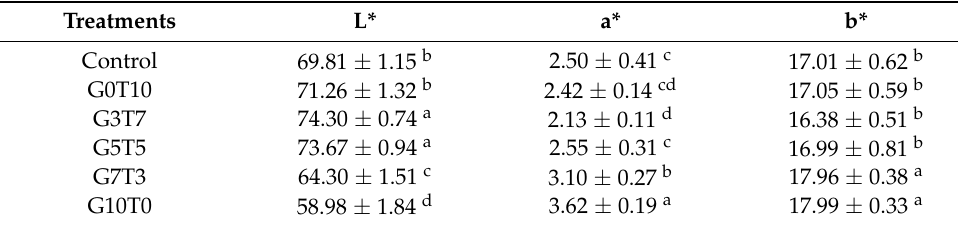
Table 2. Color of plant-based meat patties (PBMPs) with different